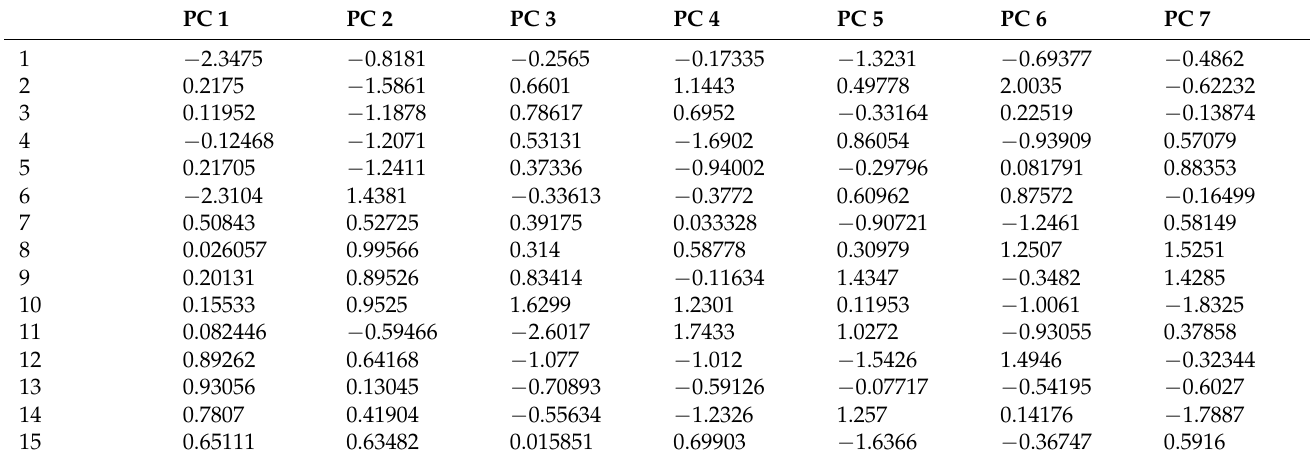
Table 8. PCA results for heavy metals in the cultured and wild Barramundi